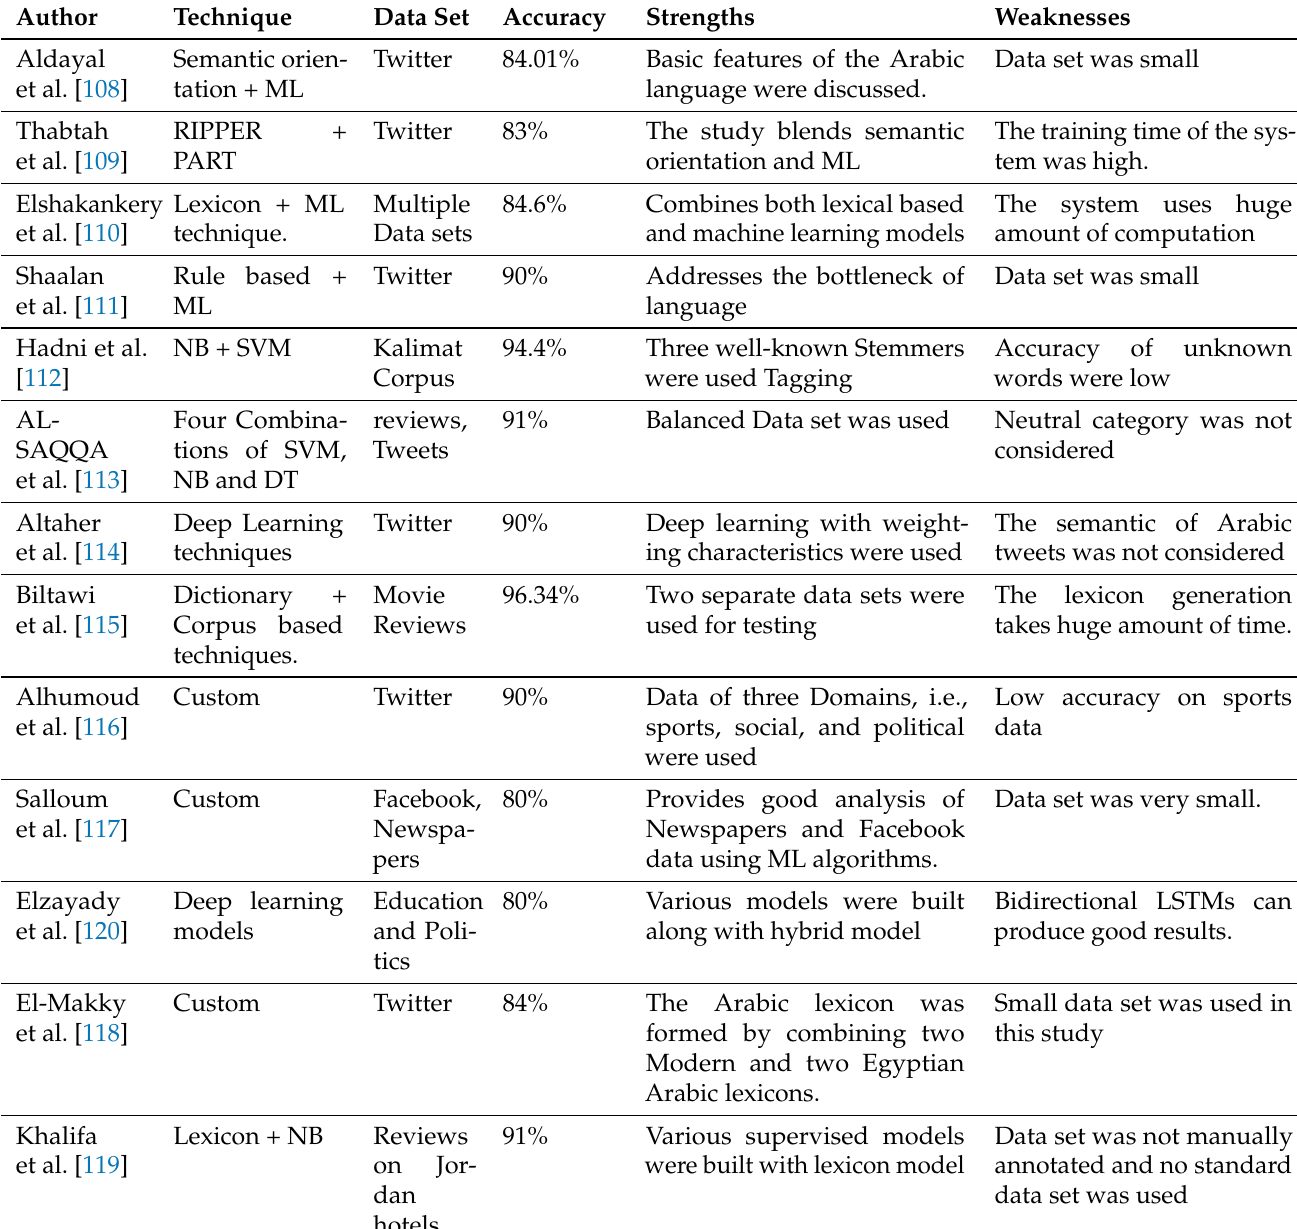
Table 4 present summary of hybrid techniques for Arabic text classification. Table 4. Comparison of Hybrid techniques used for Arabic text